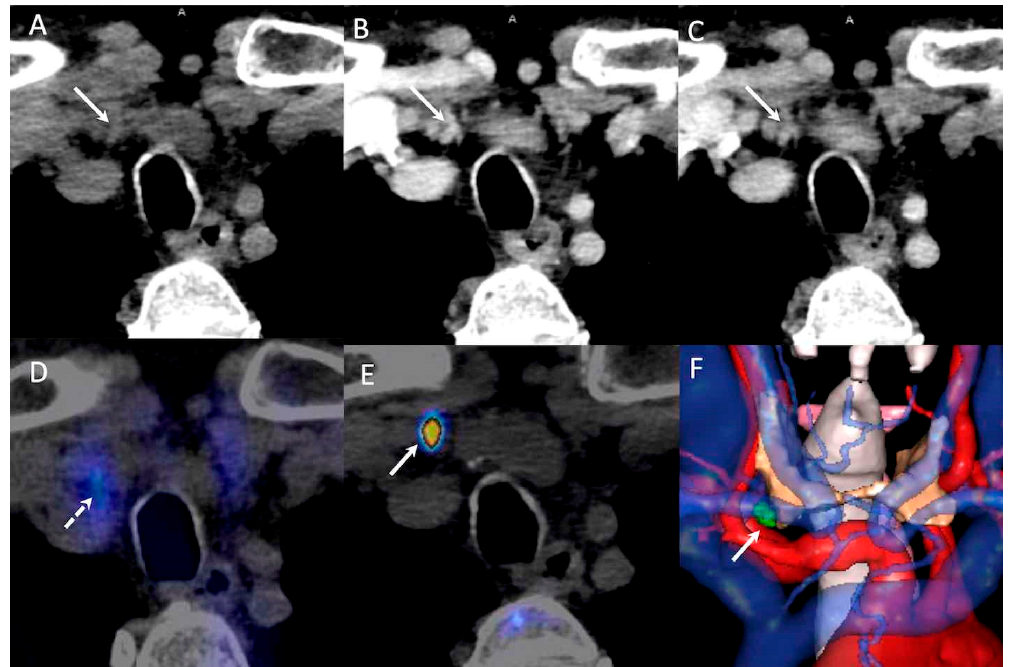
Figure 2. 79-year-old man with primary hyperparathyroidism (pHPT) and inconclusive neck ultrasonography (US) and parathyroid scintigraphy. Positron emission tomography/four-dimensional computed tomography (PET/4D-CT) identified one right retro-clavicular nodule with typical contrast-media enhancement profile and high 18 F-FCH uptake (arrow). Pathology confirmed a